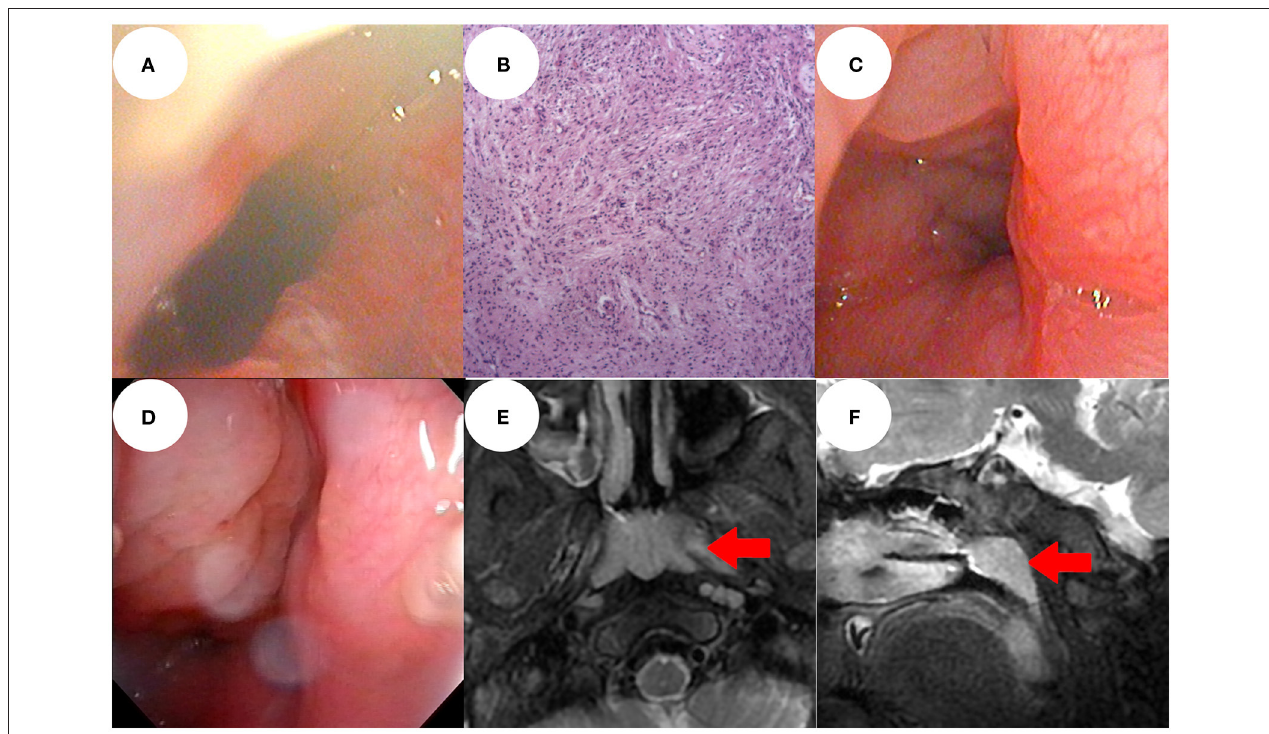
FIGURE 2 | Electronic nasopharyngoscopy 1 week after surgery showed that the operation area recovered well and there was good nasopharyngeal patency (A) . Post-operative pathological examination was performed under a 100 × lens (B) . At 1 year post-operatively, electronic nasopharyngoscopy showed no recurrence of the mass, only nasopharynx adenoid hyperplasia (C) . At the 3-year follow-up, there was no recurrence of the mass, but obvious adenoidal hyperplasia (D) . Sinus magnetic resonance imaging showed no recurrence of the mass and no intracranial abnormality, only adenoidal hyperplasia (red arrow) (E,F)